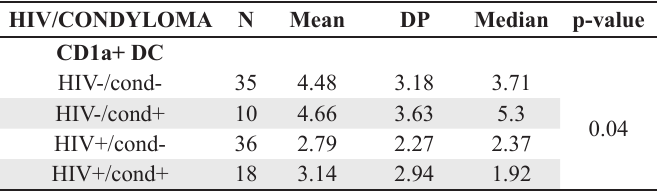
N=number of subjects, SD=standard deviation, DC=dendritic